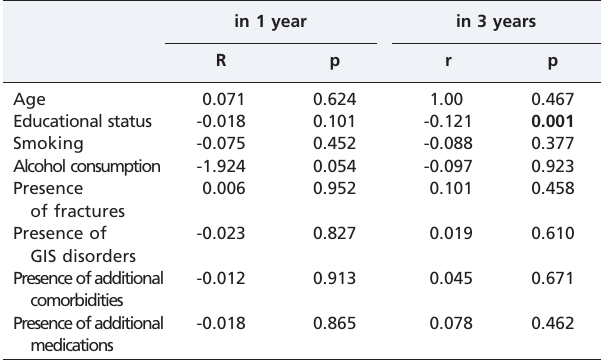
Table 3 - Comparison of demographic characteristics during the 1- and 3-year follow-ups, according to the rates of compliance and